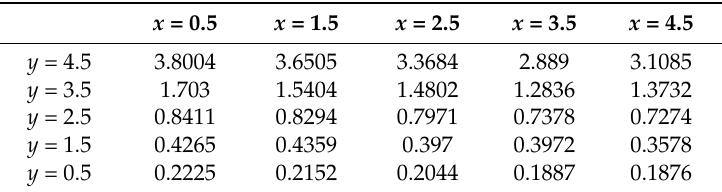
Table 1. Voltage ratios calculated ( R 1) using MATLAB.